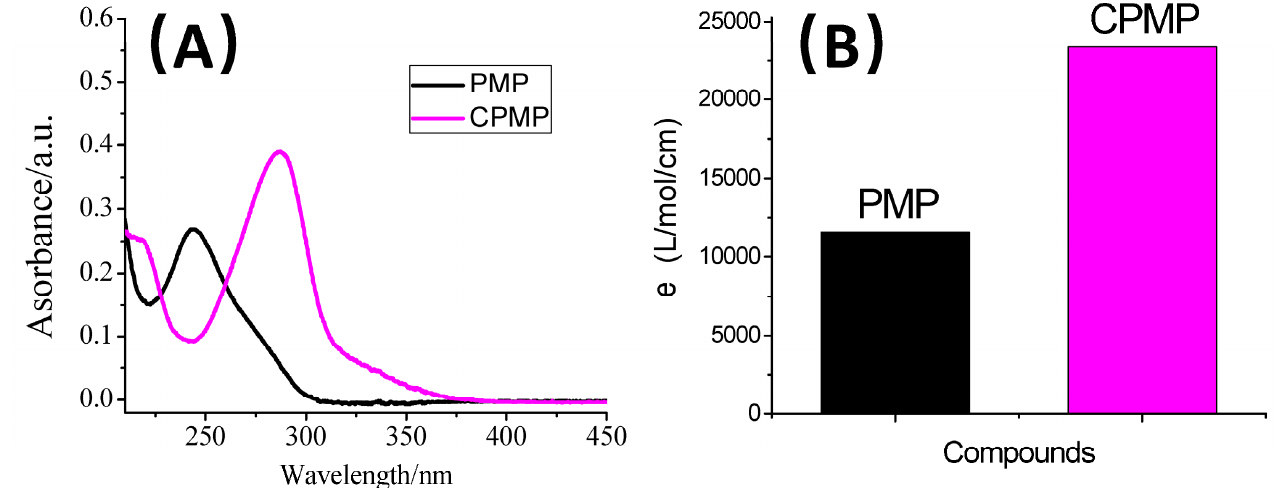
Figure 1. Spectroscopic properties of pre-column derivatization reagents of PMP and CPMP. ( A ) UV-Vis spectrum; ( B ) Molar extinction coefficient in methanol. Table 1. The values of the molar extinction coefficient of chemosensors bearing different groups.